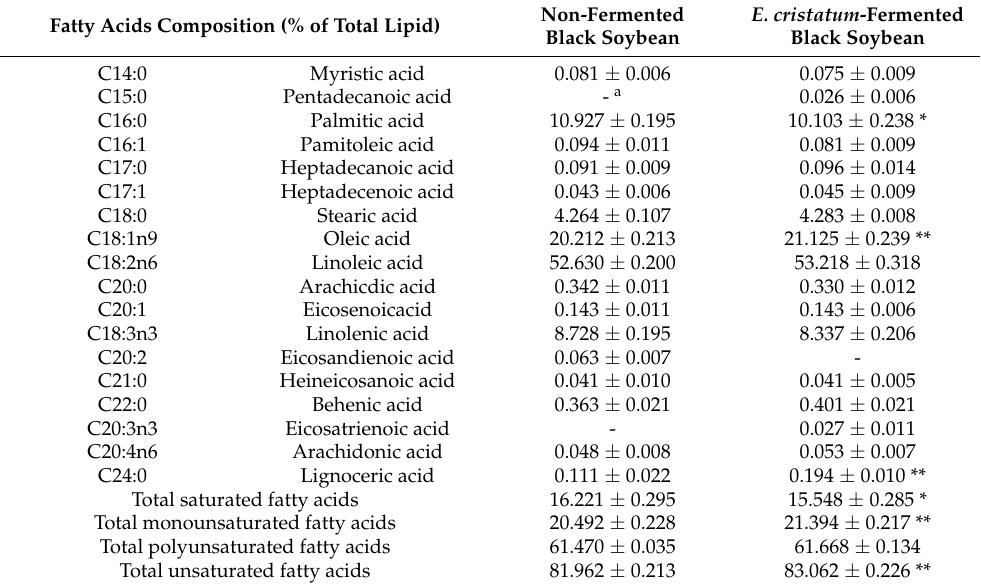
Table 4. Fatty acids composition (%) of E. cristatum -fermented and non-fermented black soybeans. Fatty Acids Composition (% of Total